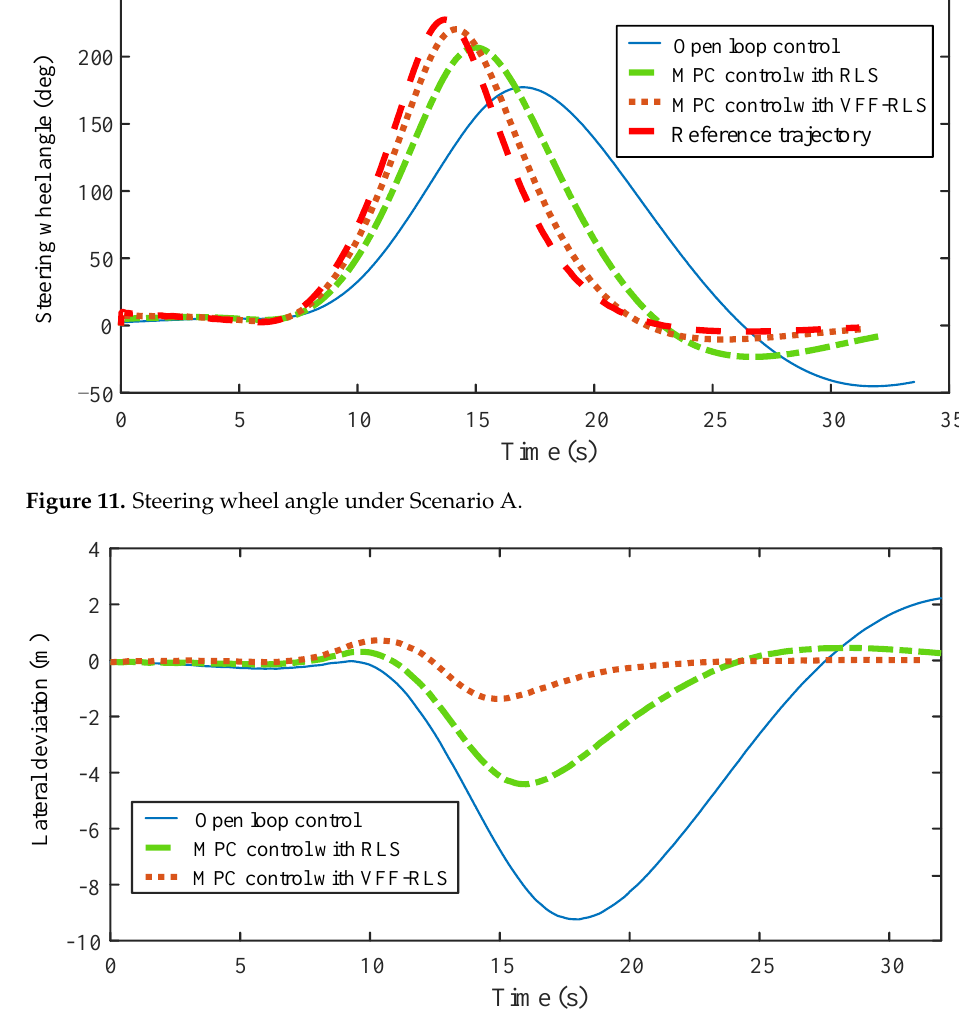
Figure 12. Lateral deviation under Scenario A.